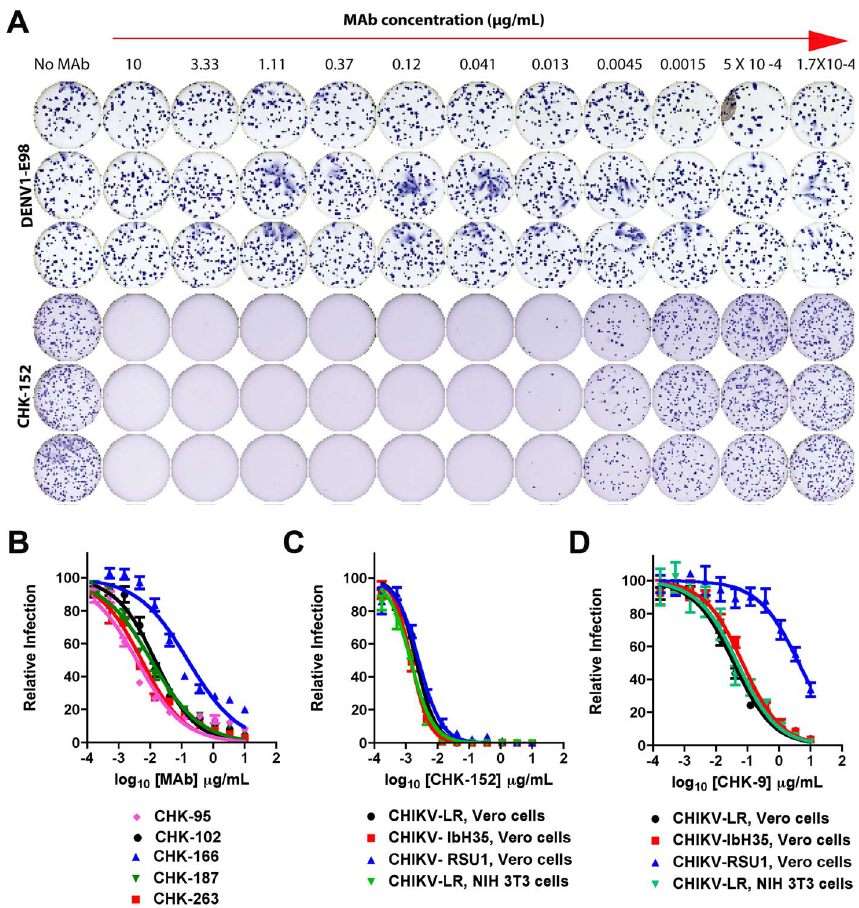
Figure 1. Profile of neutralizing MAbs against CHIKV. A . Examples of MAb neutralization as judged by a reduction in the number of FFU using the Biospot Macroanalyzer. Rows 2 to 12 going across represent decreasing (3-fold) concentrations of CHK-152 or the negative control DENV1-E98 MAb. Column 1 shows infection in the absence of MAb. B . Increasing concentrations of CHK-95, CHK-102, CHK-166, CHK-187, or CHK-263 were mixed with 100 to 150 FFU of CHIKV-LR for one hour at 37 u C and Vero cells were infected. Neutralization was determined by FFU assay. C–D . CHK-152 ( C ) or CHK-9 ( D ) was mixed with CHIKV-LR (East, Central and South African genotype), CHIKV-RSUI (Asian genotype), or CHIKV IbH35 (West African genotype) for one hour at 37 u C and Vero or NIH 3T3 cells were infected as indicated. Neutralization was determined by FFU assay. Data in this Figure is pooled from three independent experiments performed in duplicate or triplicate. All error bars represent the standard deviations.